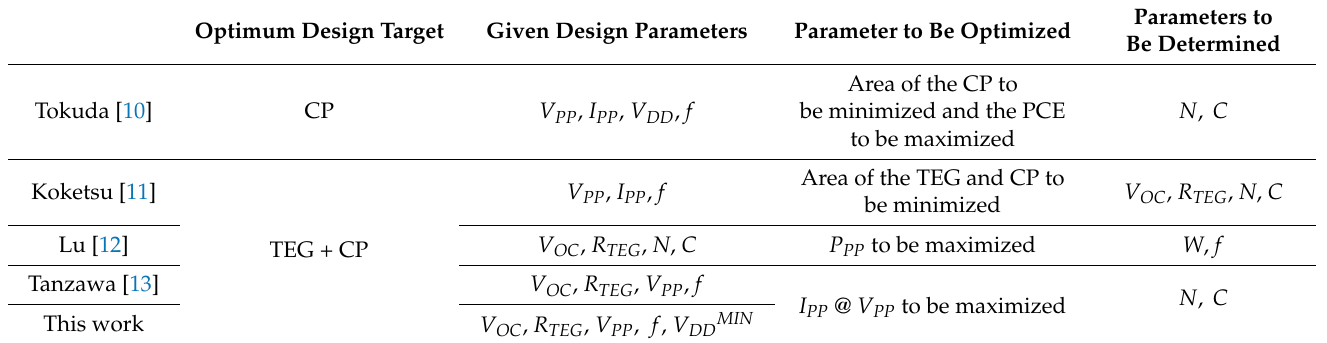
Figure 1. Block diagram of the energy harvesting system based on the TEG and CP. Table 1. Comparison of the key features of this work with existing